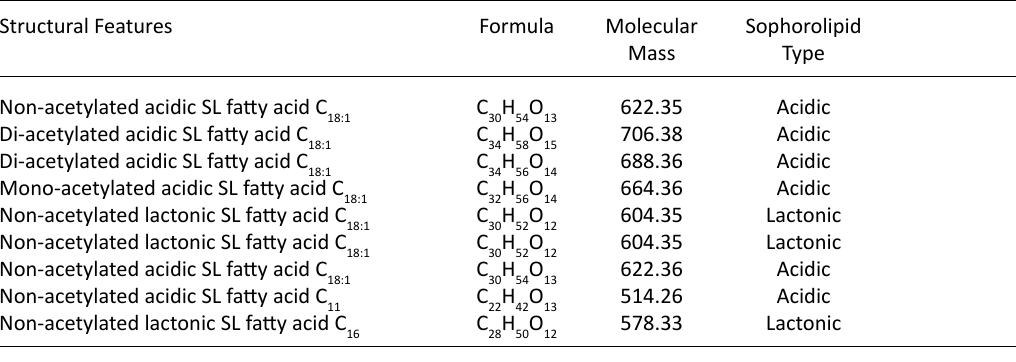
Table 2. Antibacterial activity of sophorolipid by